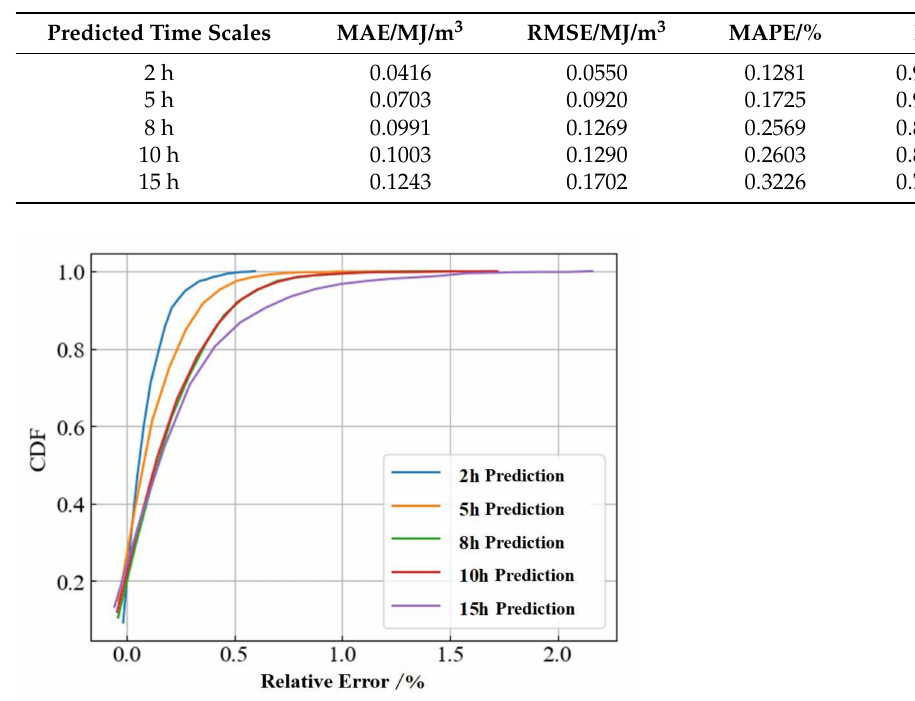
Table 5. Comparison for prediction performance under different time scales.